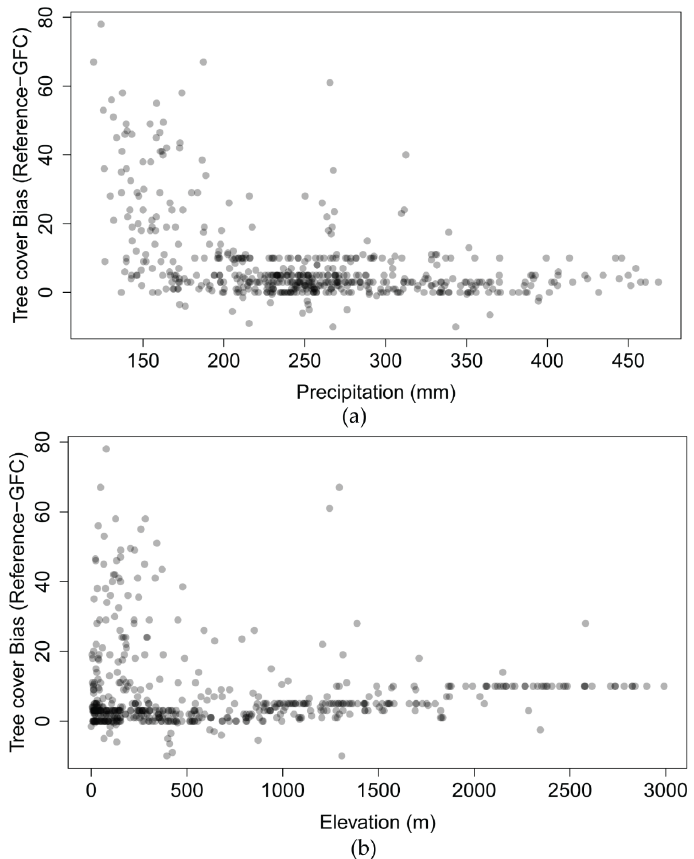
Figure 2. The distribution of the tree cover bias (i.e., the difference between reference and GFC estimates) at reference points is shown across gradients of ( a ) precipitation and ( b ) elevation, with reference points in gray. Darker areas indicate point overlap. Table 2. Model fit for prediction of bias along precipitation and elevation gradients. Model fit was assessed using root-squared mean deviance (RSMD) between sample and model-predicted bias, and using model trend direction for the conditional partial terms (elevation and precipitation). Models included linear regression (OLS reg.), quantitative median regression (quant. reg.), a CART decision tree (CART), and a general additive model (GAM).